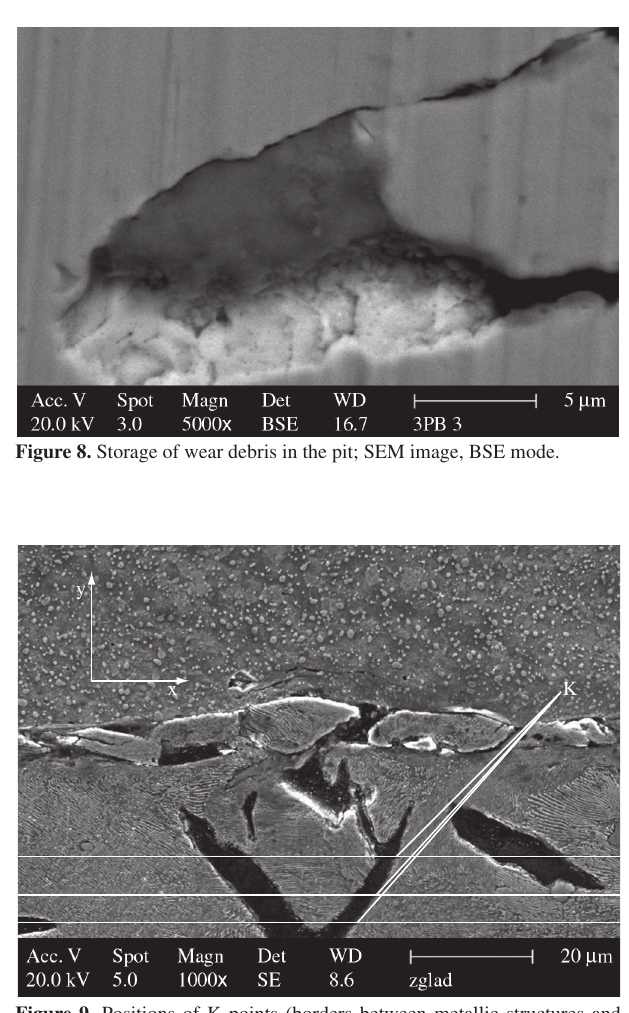
Figure 11. Position of graphite flakes in relation to disc brake operating